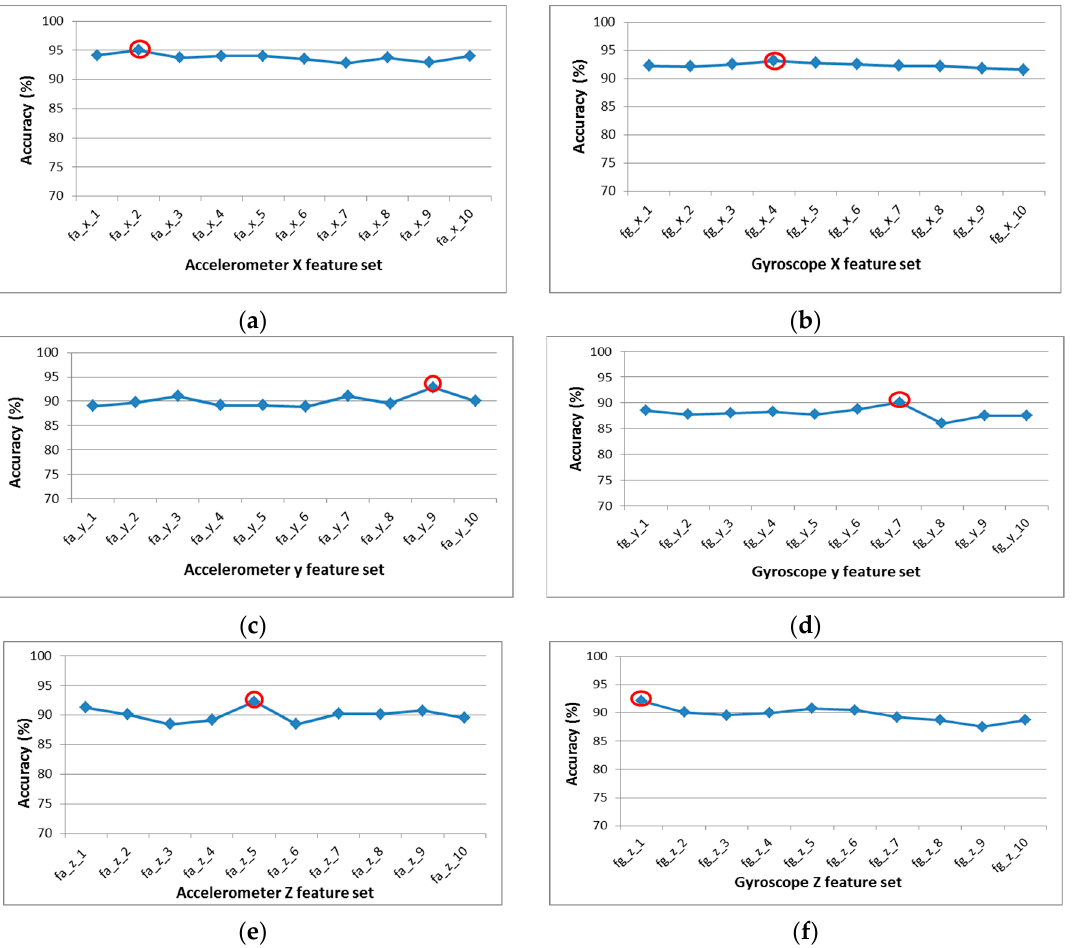
Figure 8. Accuracy of different feature sets produced by support vector machine in wrapper method. Highest accuracy is mark in red circle: ( a ) Accelerometer X-axial feature set; ( b ) accelerometer Y-axial feature set; ( c ) accelerometer Z-axial feature set; ( d ) gyroscope X-axial feature set; ( e ) gyroscope Y-axial feature set; ( f ) gyroscope Z-axial feature set. Table 3. Overall classification accuracy of final optimal features in wrapper approach in hybrid feature selection.